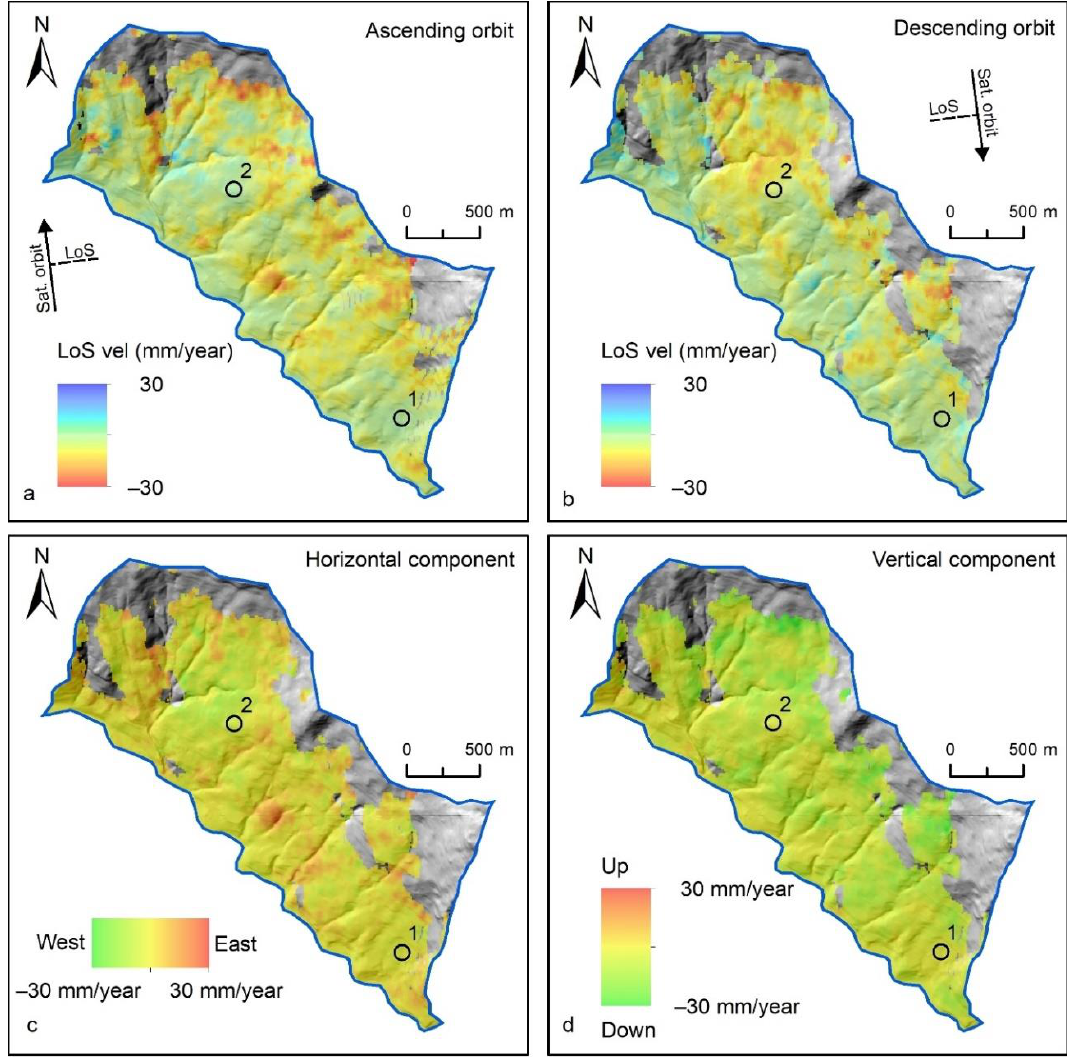
Figure 6. Velocity maps derived by the SBAS processing of ascending ( a ) and descending ( b ) SAR images. Horizontal and vertical components of velocity are also reported in ( c ) and ( d ), respectively. Black circles indicate the location of the two sites investigated in more detail: Cappellazzi district (1) and Rovegliana Church (2).